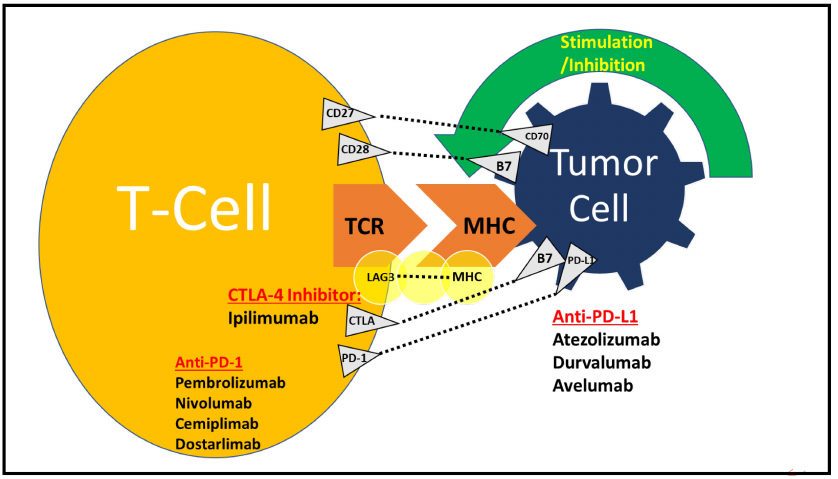
Figure 1. Mechanism of action of PD-1/PD-L1 and CTLA4 inhibitors. Antigen presentation oc- curs on the surfaces of antigen-presenting cells (APCs) via T-cell receptors (TCR) and major his- tocompatibility complex (MHC). There are stimulatory and inhibitory signals, such as cytotoxic T-lymphocyte-associated protein 4 (CTLA-4) and programmed cell death-1 (PD-1). Some of the upregulators of T-cells and their cognate ligands are CD27-CD70 and CD28-B7. Inhibitory T-cell receptors and their ligands include LAG3-MHC, CTLA4-B7 and PD1-PDL1. CTLA-4 reduces sig- naling via its co-stimulatory receptor, CD28, by binding to CD80 and CD86 on APC. CTLA-4 sends an inhibitory signal to T-cells. A CTLA-4 inhibitor (ipilimumab) stops autoreactive T-cells. PD-1 binds to programmed death-ligand 1 (PD-L1), which results in cancer evasion from the immune system. Blockade of PD-1 (via pembrolizumab, nivolumab, cemiplimab or dostarlimab) or PD-L1 (via atezolizumab, durvalumab or avelumab) increases anti-tumor immune activity. The image used has been modified from a prior submission [11].